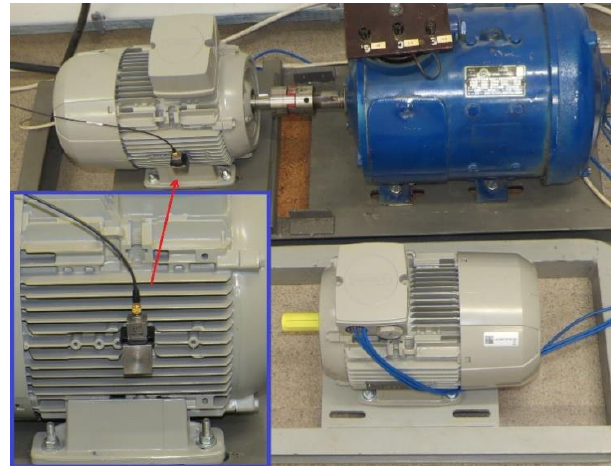
Figure 1. Motors 4-p4 and the accelerometer (bottom left).